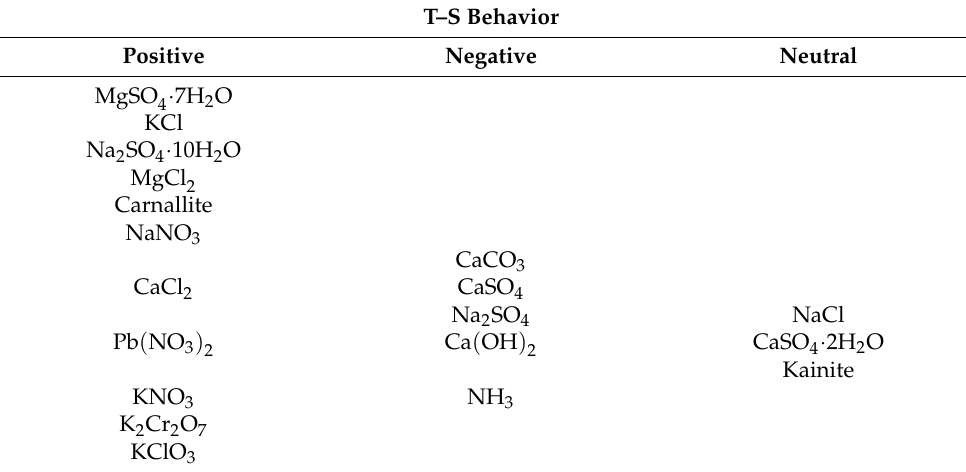
Table 1. Examples of solutes with different T–S behaviors [3,4].